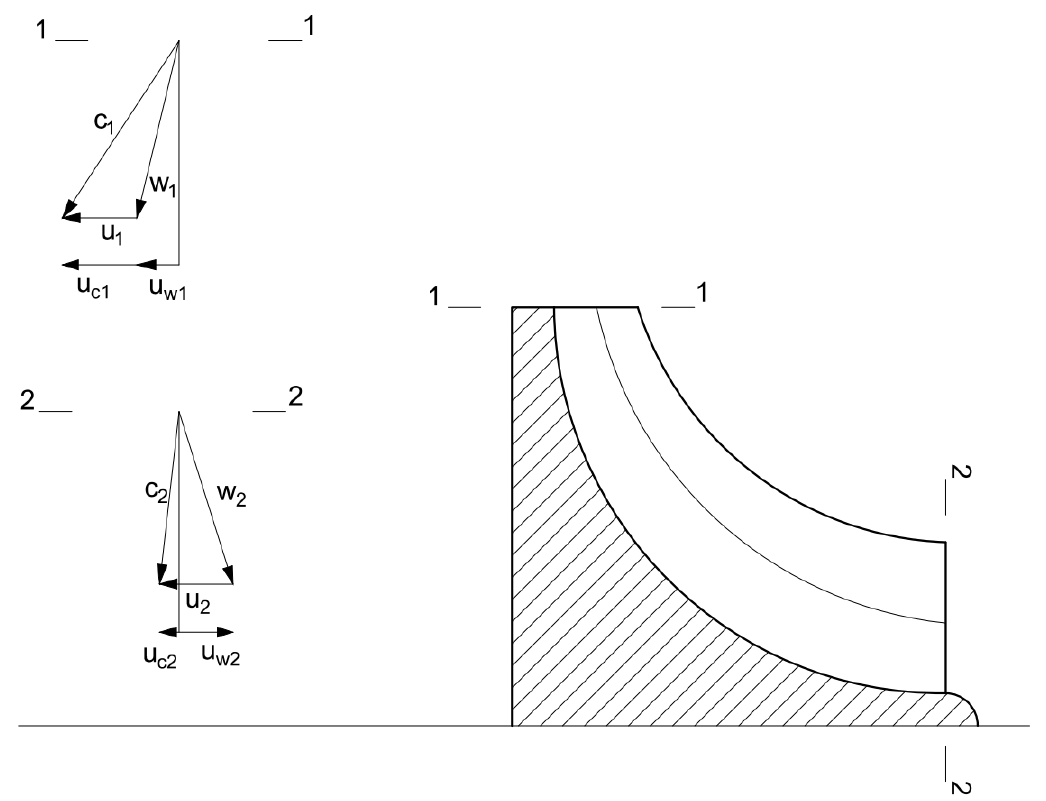
Energies 2023 , 16 , x FOR PEER REVIEW 30 of 48 Figure 27. The turbine velocity triangle at the rotor inlet (1 — 1) and rotor outlet (2 — 2). Figure 27. The turbine velocity triangle at the rotor inlet (1—1) and rotor outlet (2—2).